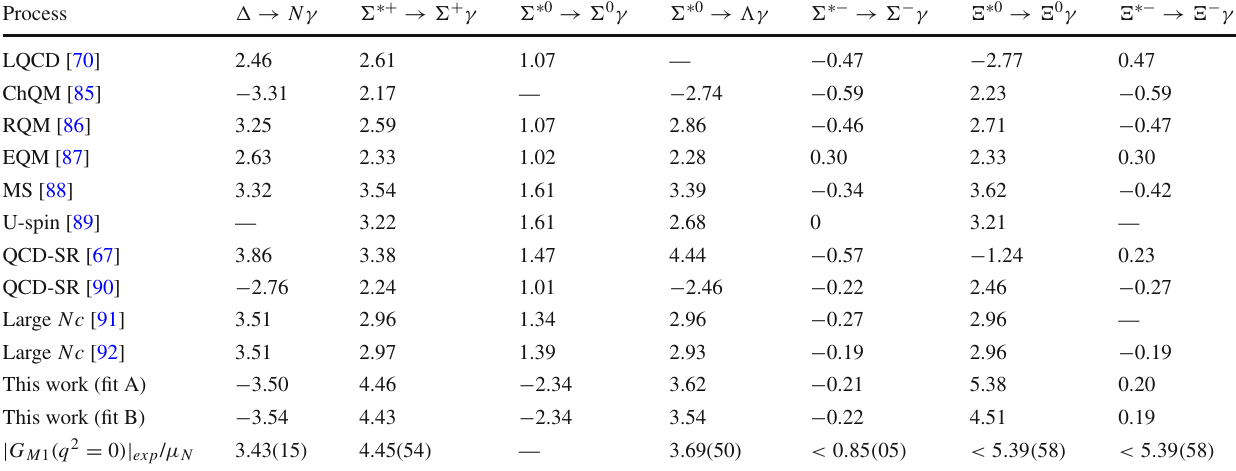
Table5 Comparisonofthedecuplettooctetbaryontransitionmagnetic moments in literature including lattice QCD (LQCD) [70], chiral quark model (ChQM) [85], relativistic quark model (RQM) [86], effective mass quark model (EQM) [87], meson cloud (MS) [88], U-spin [89],